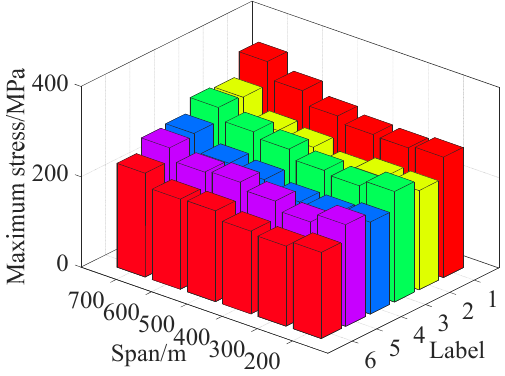
Figure 11. Extreme response stresses.